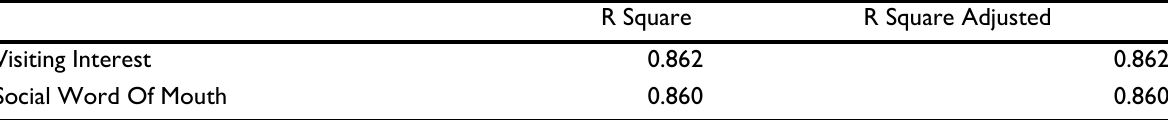
Table 5. Coefficient of Determination